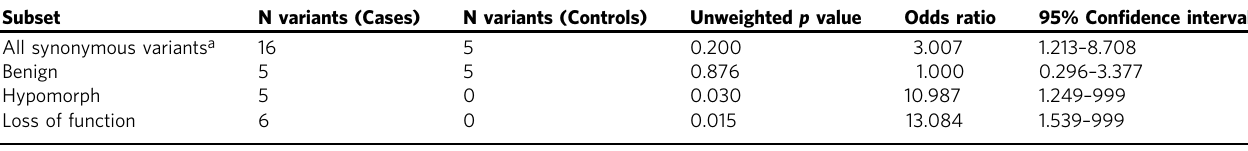
Table 2 Cohort 1: Discovery cohort, Gene-based association of PCM1 and ASZ using ultra-rare functional variants. Subset N variants (Cases) All synonymous variants a